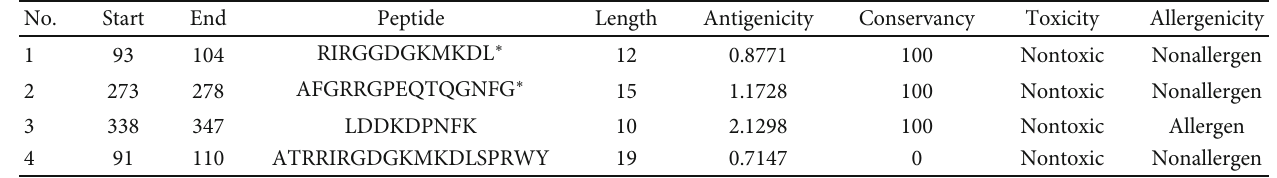
Table 1: B cell linear epitopes of SARS-CoV-2 NP and their toxicity properties.